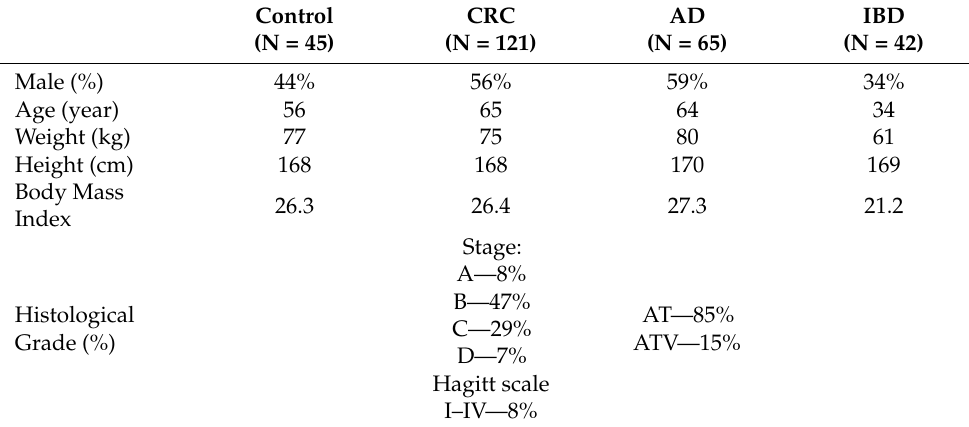
Table 2. Baseline characteristics of the study